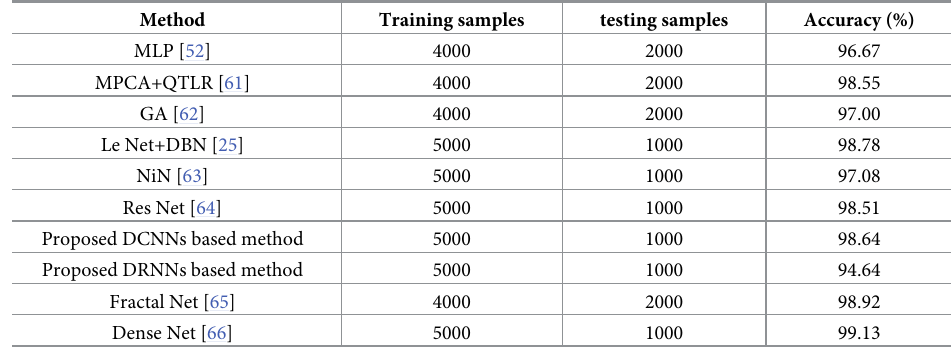
Table 5. Performance comparison of the proposed method with SOA on CMATERdb 3.1.1